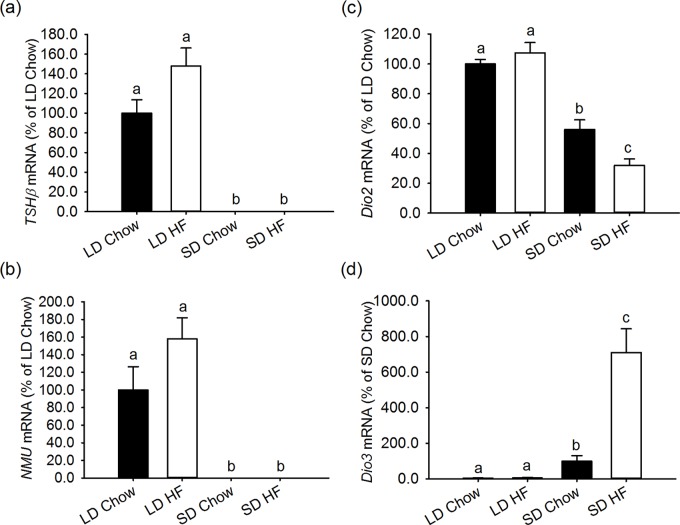
Effect of photoperiod and high fat diet (HFD) on gene expression of TSHβ and NMU in the pars tuberalis of the pituitary and Dio2 and Dio3 in the tanycytes around the third ventricle in juvenile F344 rats after 4 weeks of treatment.Gene expression was measured by quantitative in situ hybridisation. (a,b) Expression of TSHβ (a) and NMU (b) mRNAs in the pars tuberalis were significantly lower in both chow and HFD fed SD compared to LD rats. (c) Dio2 mRNA levels in the ependymal cells around the 3rd ventricle were lower in SD than LD chow and HFD fed rats (p<0.001). HFD reduced Dio2 further in SD compared to LD conditions (p<0.001). (d) Dio3 mRNA expression was higher in SD than LD rats. HFD increased the Dio3 mRNA level significantly in SD (p<0.001), but not in LD.